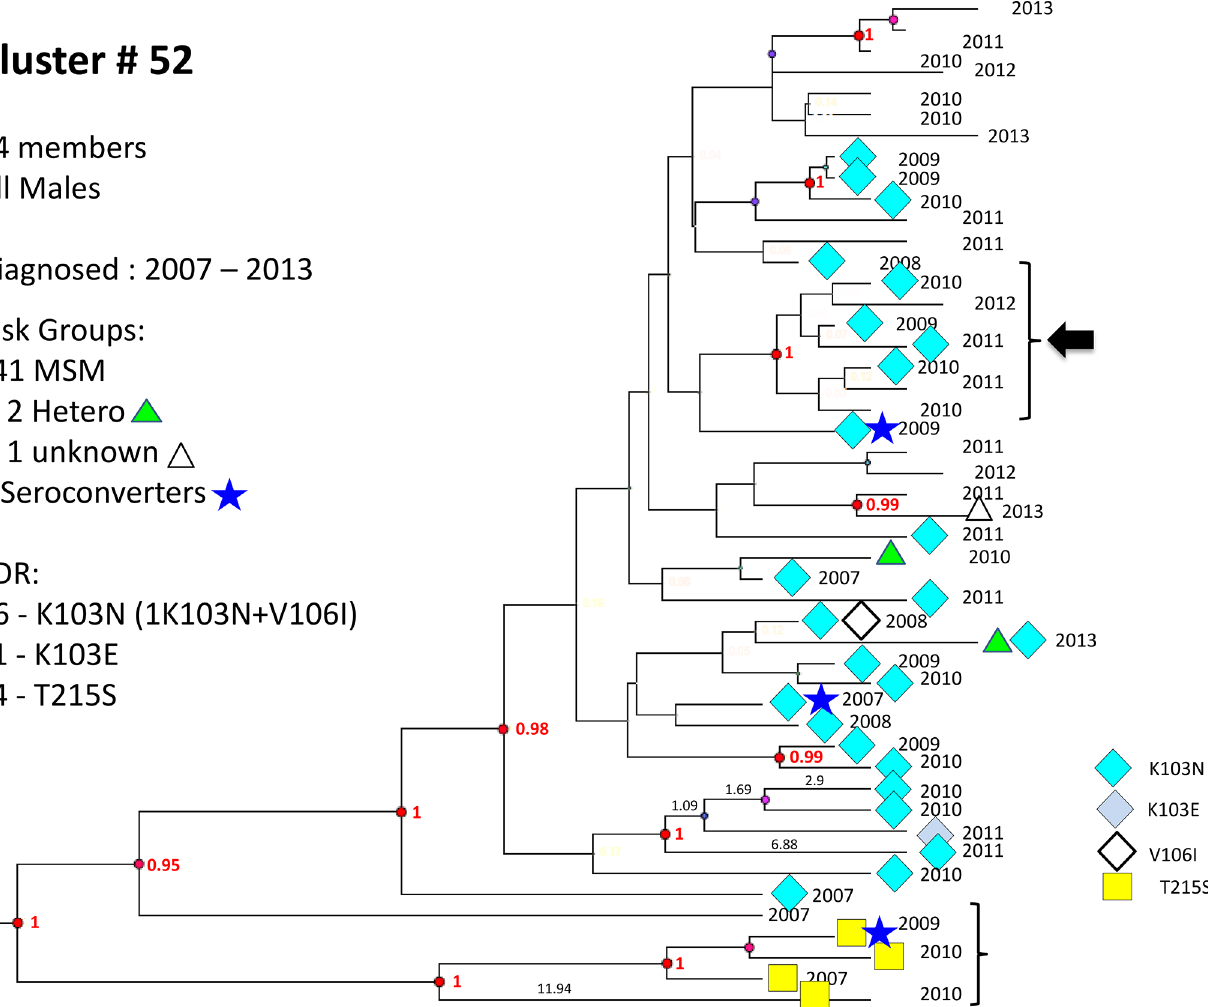
Fig 6. Cluster # 52. Cluster 52 is composed of 48 males, diagnosed and genotyped between 2007 and 2013. 26 harbored K103N, one K103E, and 4 had T215S. The group contains 3 seroconverters who were diagnosed 3 years apart (in 2007 and 2009). A transmission network of 7 members is noted (arrow). Notations as in Fig